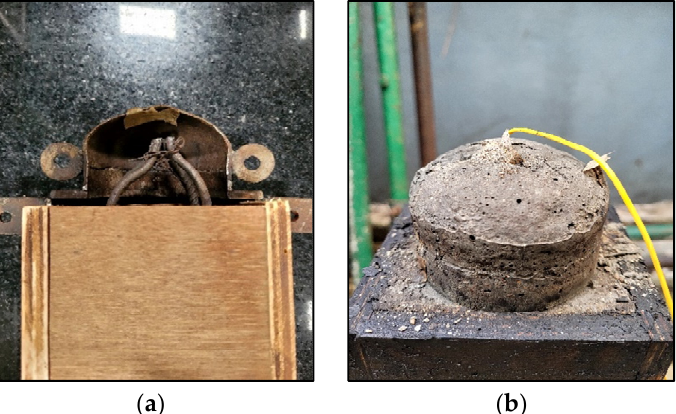
Figure 14. ( a ) Representation of the extension of the main reinforcement to the mimicked part. ( b ) Demolded image of the mimicked part. ( b ) Demolded image of the mimicked part.